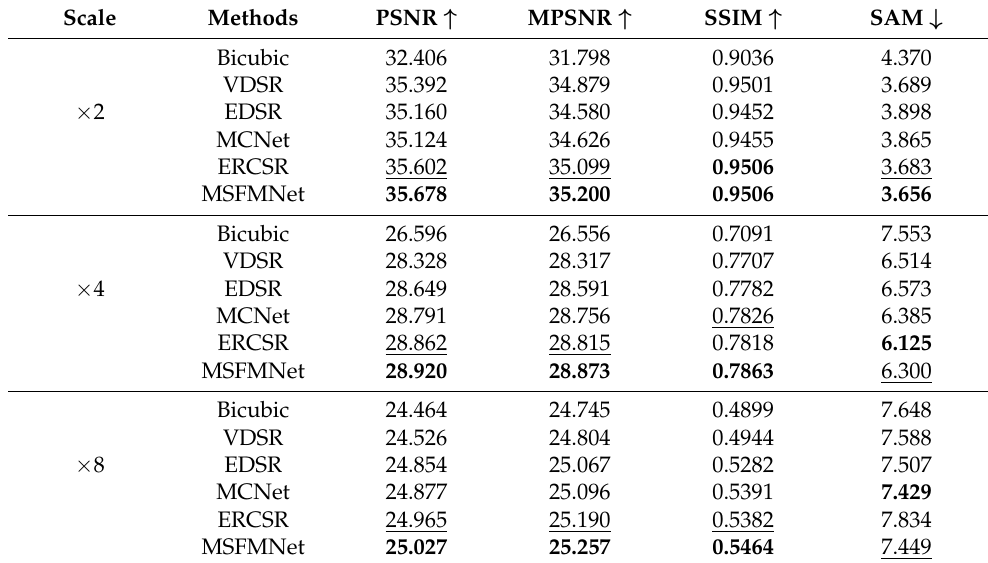
Bold values represent the best result and underlined values represent the second best.